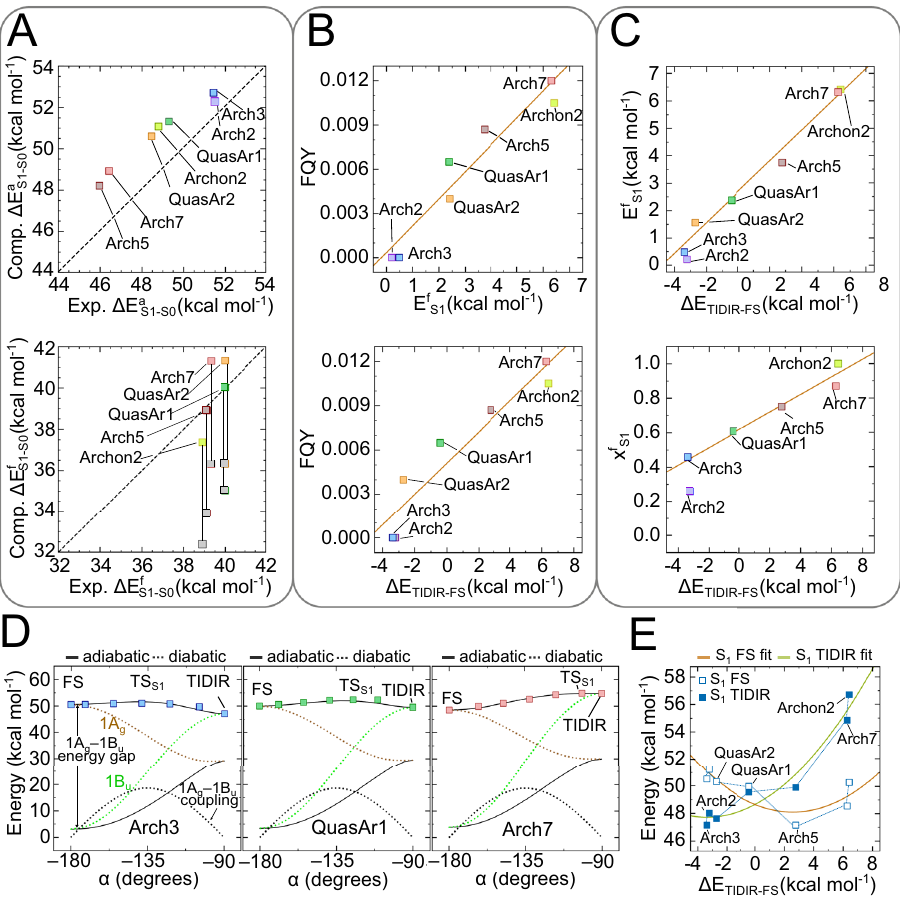
Fig. 3 | Relationship between computed S 1 isomerization properties and observedFQYalongtheArch-set.A Comparisonbetweencomputedandobserved excitation energies associated with light absorption at the ground state equilibrium structure (top) and light emission from the fl uorescent state (bottom). Vertical excitation energy associated to emission features a correction of 4.5kcalmol − 1 to account for kinetic energy derived from ref. 24. Gray and colored squares represent the emissions before and after correction, respectively. B Relationship between S 1 isomerization barrier and FQY (top) and between S 1 isomerization energy and FQY